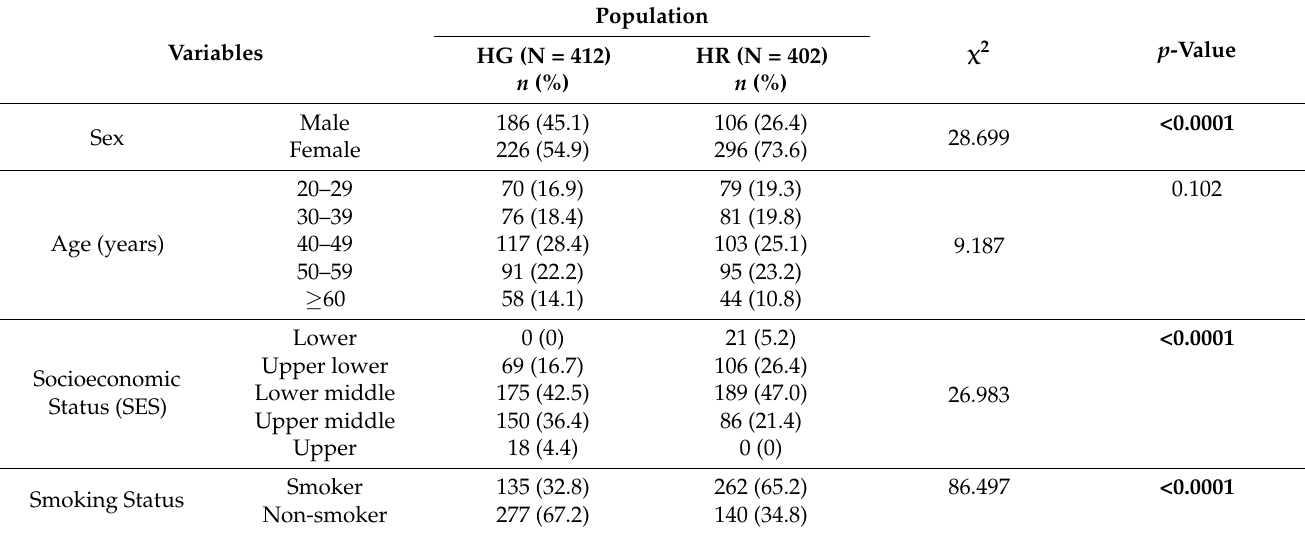
Table 1. Characteristics of the study